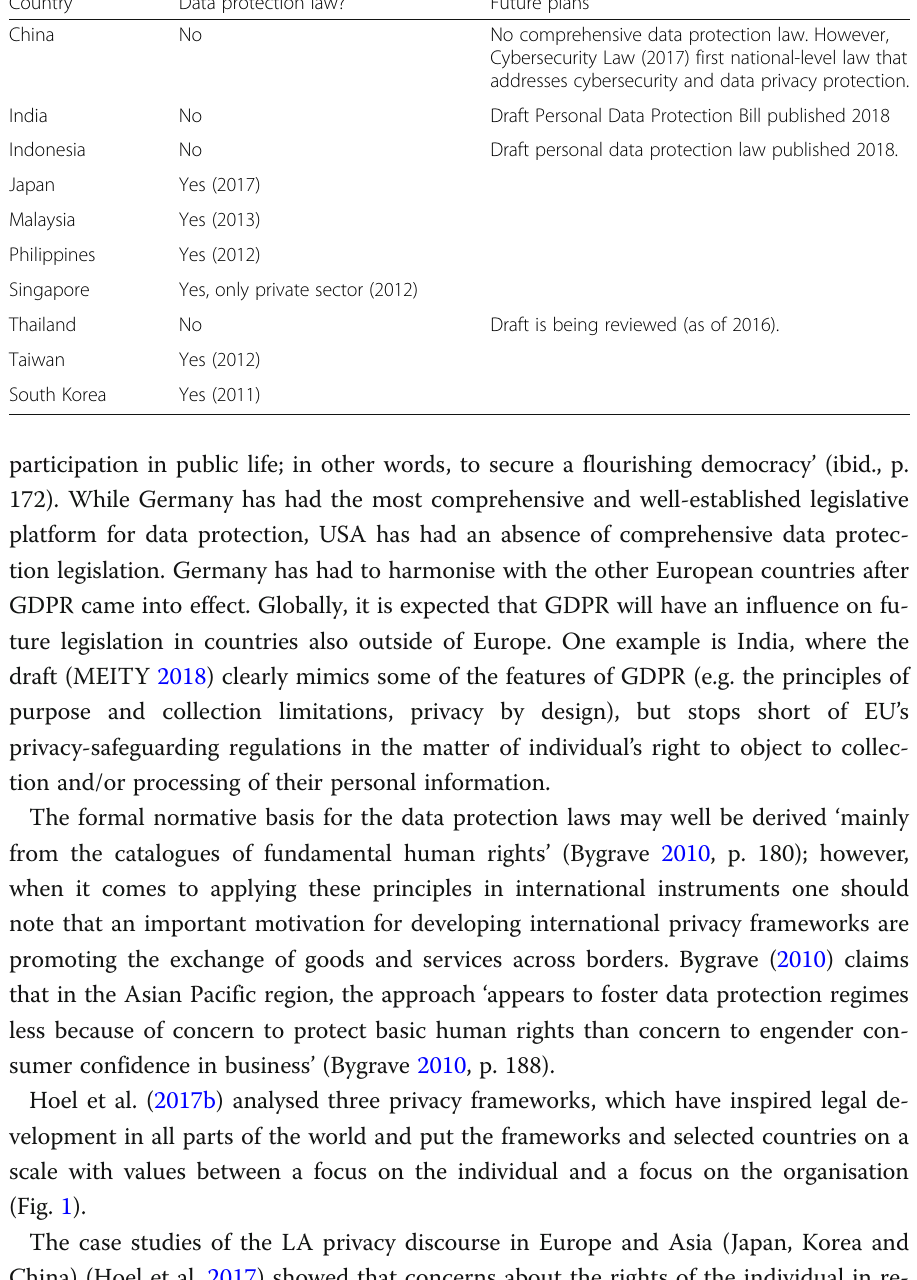
Table 1 Status data protection laws in some Asian countries (Primary source: DLA Piper 2017)